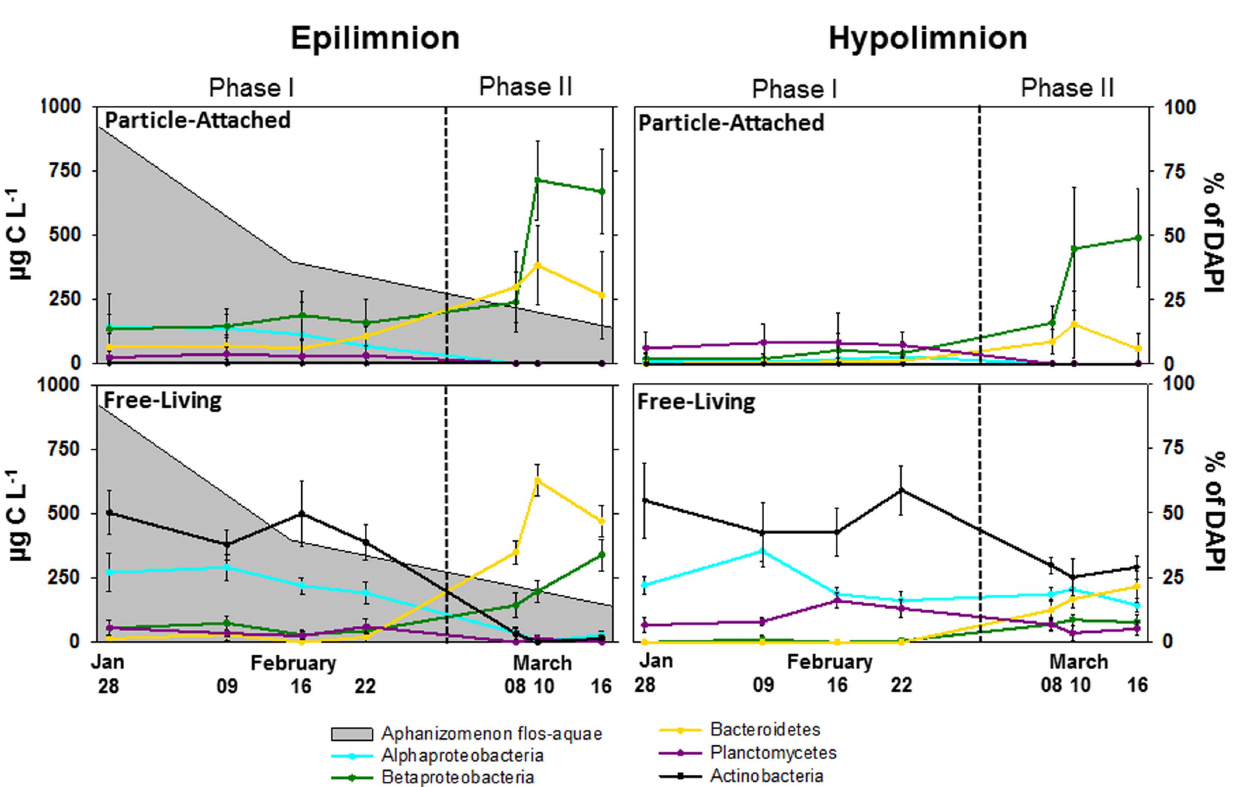
Figure 5. Distribution of relative abundances of major phylogenetic groups (% of DAPI - right axis): Alphaproteobacteria , Betaproteobacteria , Bacteroidetes , Planctomycetes and Actinobacteria as assessed by CARD-FISH in the particle-attached and free-living fractions in both epilimnion and hypolimnion. Phase I and II of the bloom are separated by the dashed line. The abundance of Aphanizomenon flos - aquae (gray field) is presented during both phases of the bloom (left